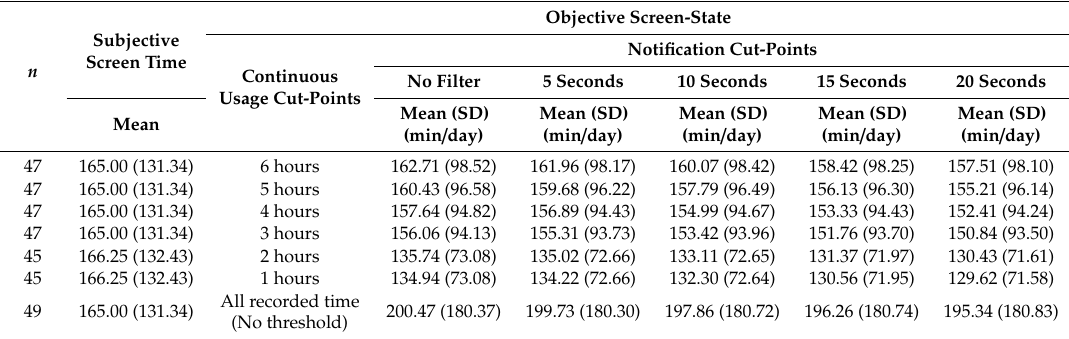
Table 1. Objective screen-state vs. subjective screen time on weekdays (minutes / day) ¥ .